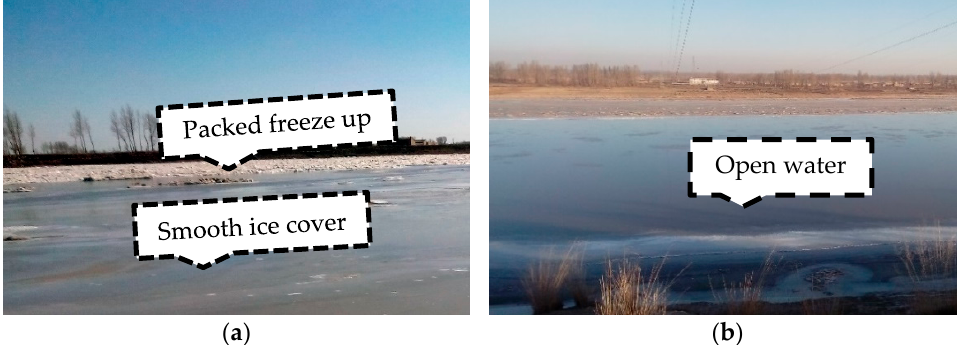
Figure 4. The freeze-up form of the Shensifenzi bend, monitored in the field. ( a ) Freeze-up forms in the bend. ( b ) Open water leads downstream of bend.